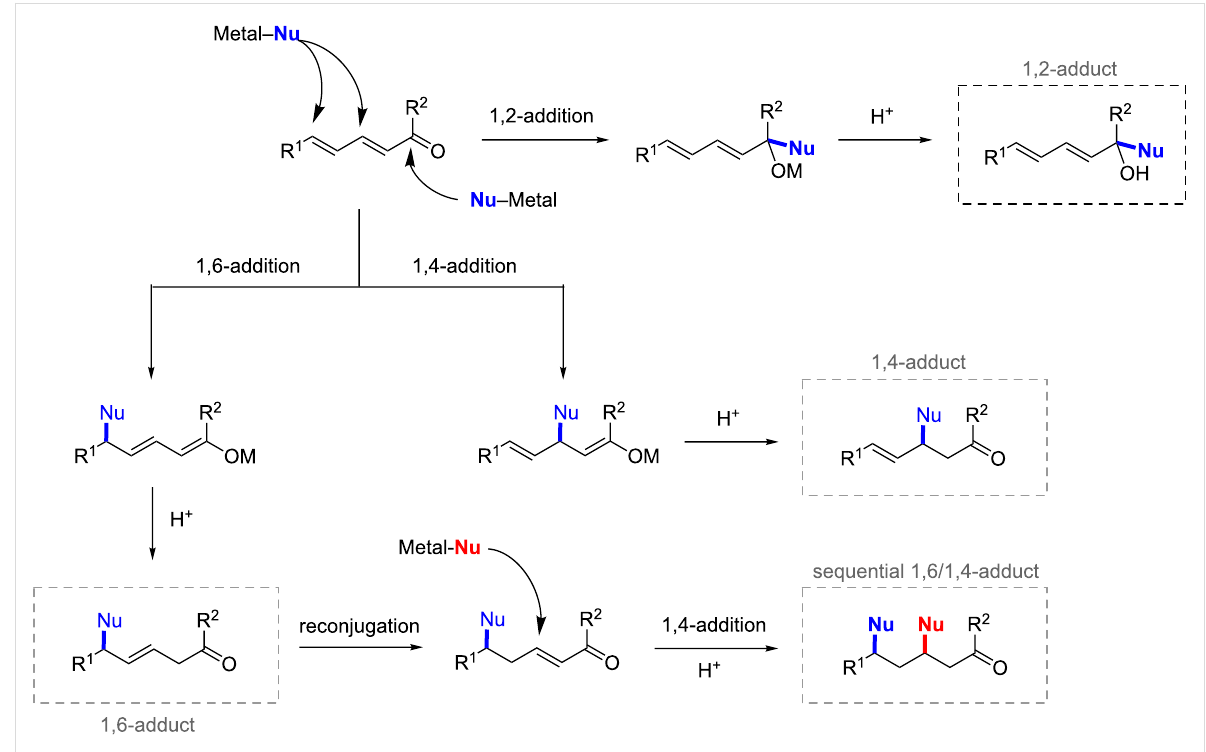
Figure 1: Possible reaction pathways in conjugate additions of nucleophiles on extended Michael acceptors.